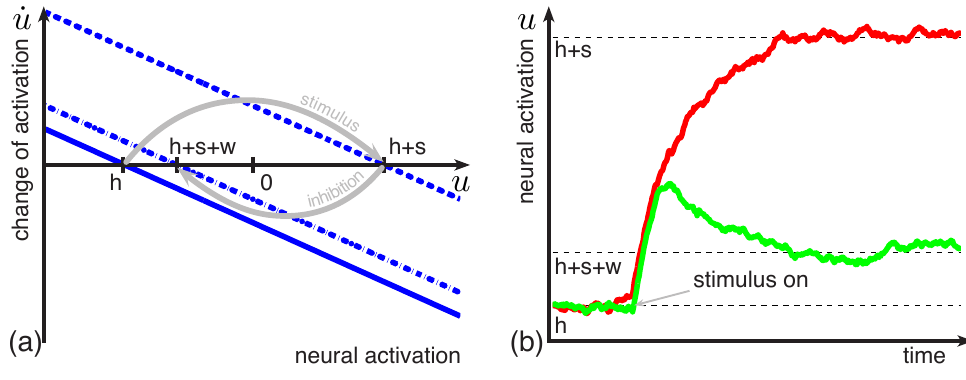
Figure 13: Panel (a) shows example phase plots of one out of two neurons with mutual inhibition (Equation 13) for three different parameter settings. With no stimulus and no inhibition from the other neuron (solid line) the attractor is at the resting level. Presenting a stimulus (dashed line) shifts the attractor to the positive region. Inhibition from the other neuron (dash-dotted line) shifts it back to the negative region again, as indicated by the grey arrows. Example trajectories for both neurons are shown in panel